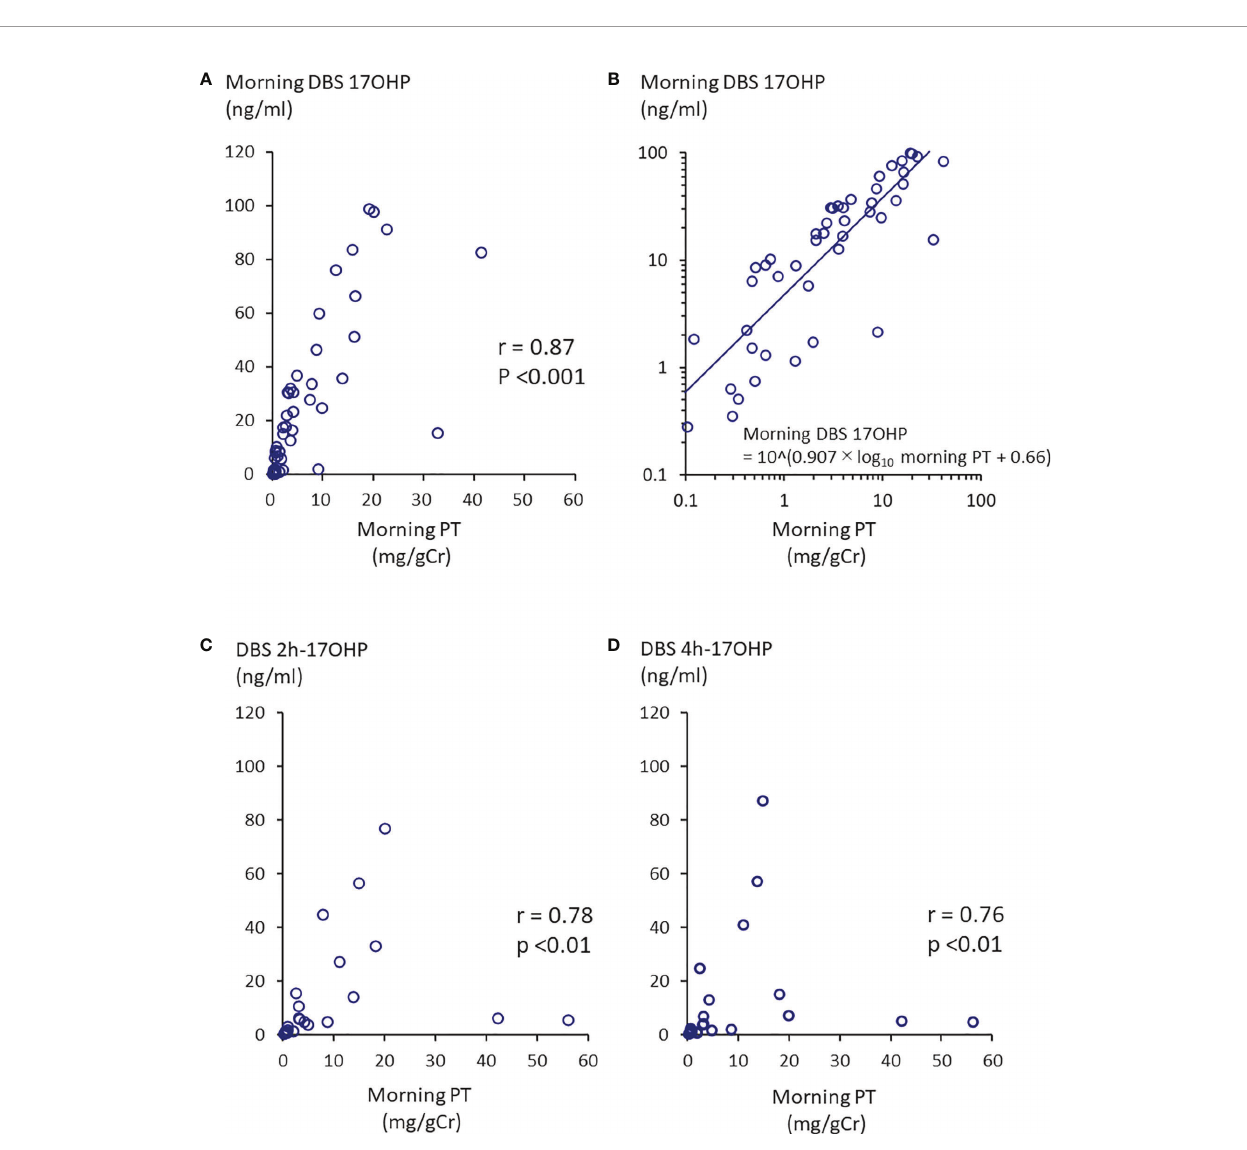
FIGURE 1 | Correlation between morning PT and 17OHP. (A) Morning PT and morning DBS 17OHP showed a signi fi cant correlation (n =46, p <0.0001, r =0.87). (B) Regression formula between morning PT and morning DBS 17OHP. By log transformation, morning PT values were normally distributed. There were weaker correlations between (C) morning PT and 17OHP at 2 hours after morning GC administration (DBS 2h-17OHP) and (D) morning PT and 17OHP at 4 hours after morning GC administration (DBS